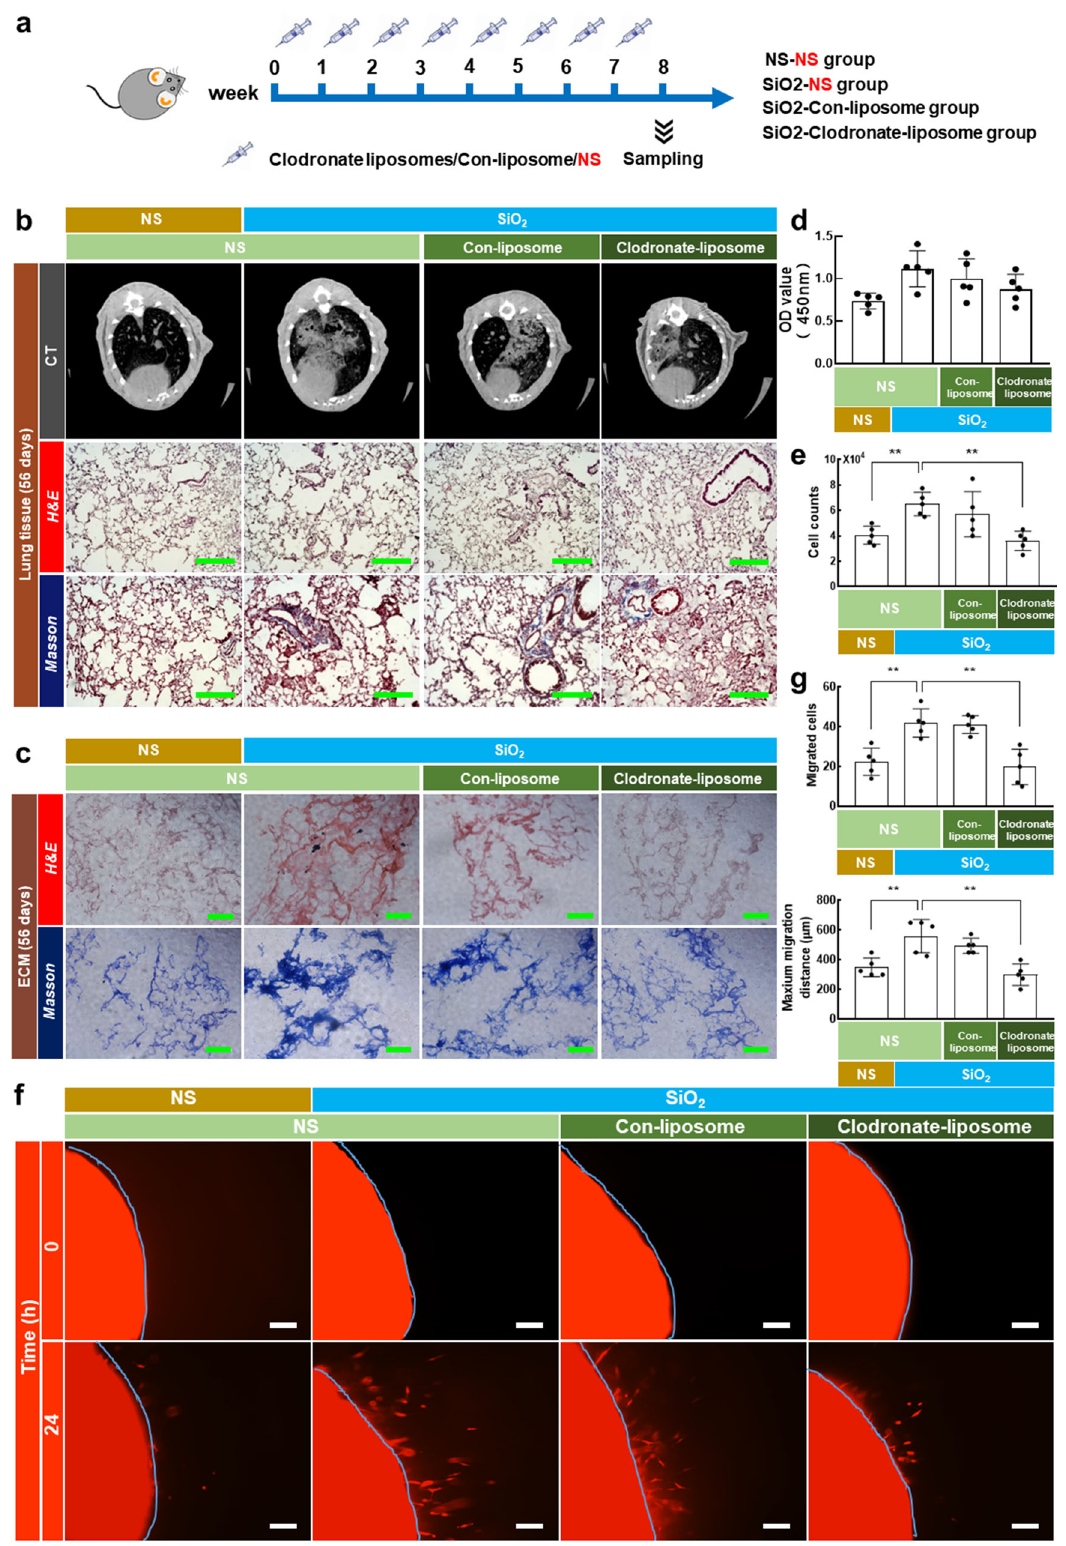
Fig. 5 Macrophage deletion via clodronate liposomes relieved PF and fi brotic ECM affected normal fi broblast behaviors in silicosis mice. a Design of the macrophage deletion experiment. b CT images, H&E staining, and Masson ’ s trichrome staining of lung tissue; scale bar = 200 μ m. c H&E staining and Masson trichrome staining of ECM; scale bar = 200 μ m. d , e Changes in cell viability and fi broblast numbers in the fi brotic ECM of silicosis mice after macrophage deletion; n ≥ 5 independent experiments, *** p < 0.001, ** p < 0.01. f , g The effect of macrophage deletion on fi broblast migration induced by fi brotic ECM; scale bar = 200 μ m, n ≥ 5 independent experiments, ** p < 0.01. NS, normal